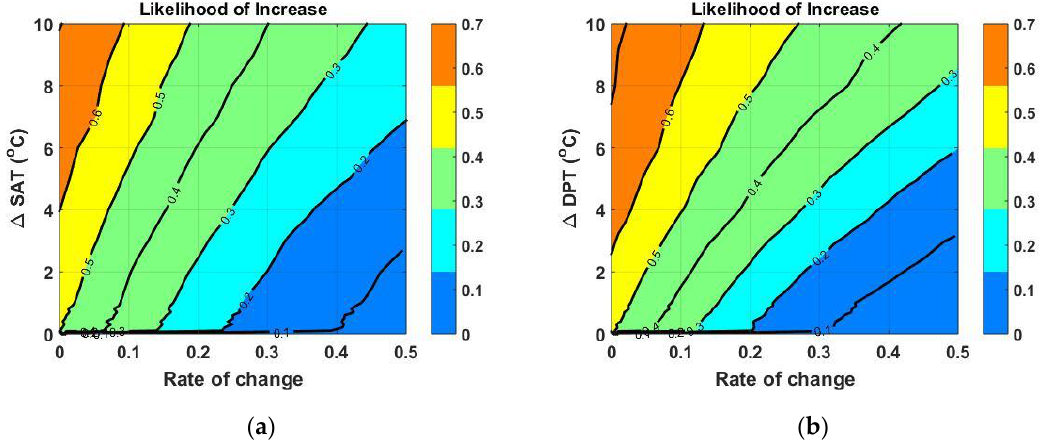
Figure 8. Likelihood of increase of rate of change under ( a ) SAT increment at the Chuncheon site, and ( b ) DPT increment at the Cheonan site.